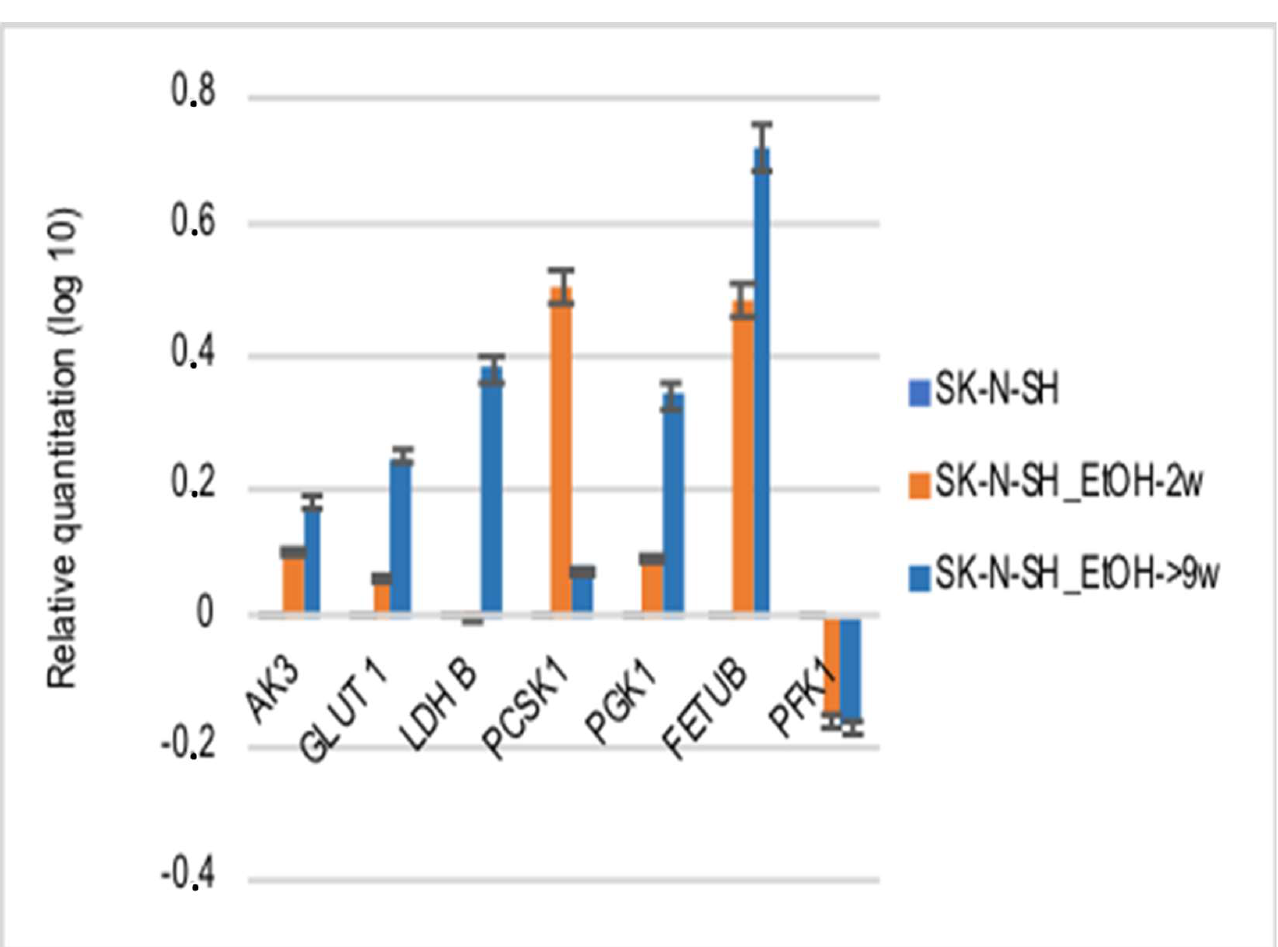
Figure 7. The effects of ethanol treatment on the expression of the gene that codes metabolic en- zymes.